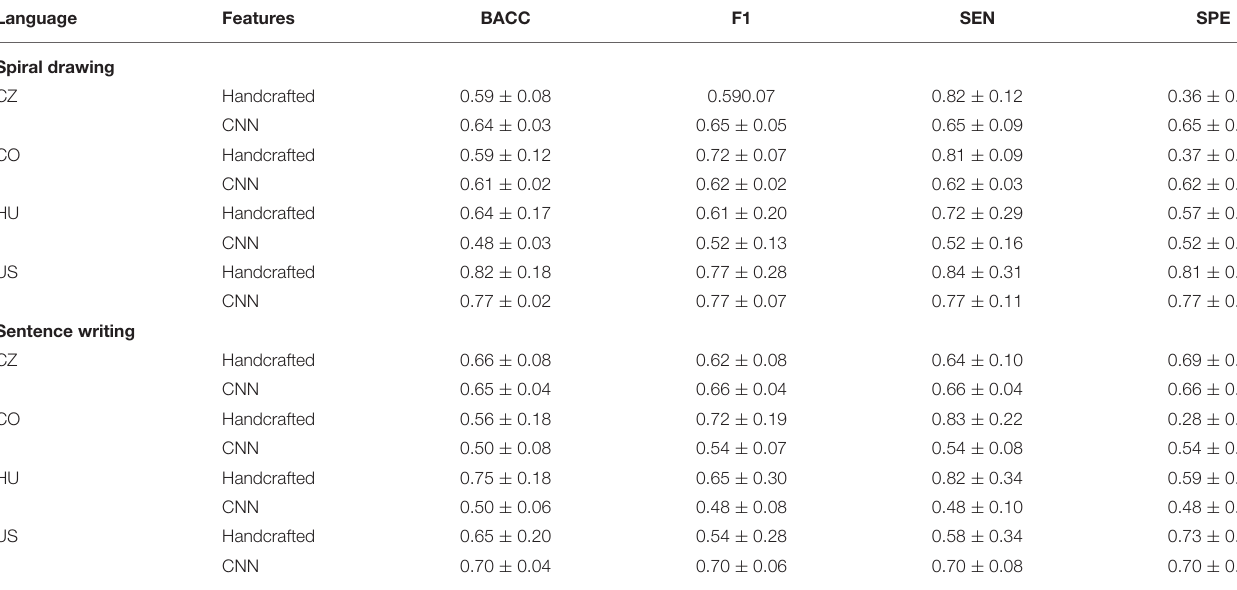
TABLE 4 | Classification performance in the single-language scenario.